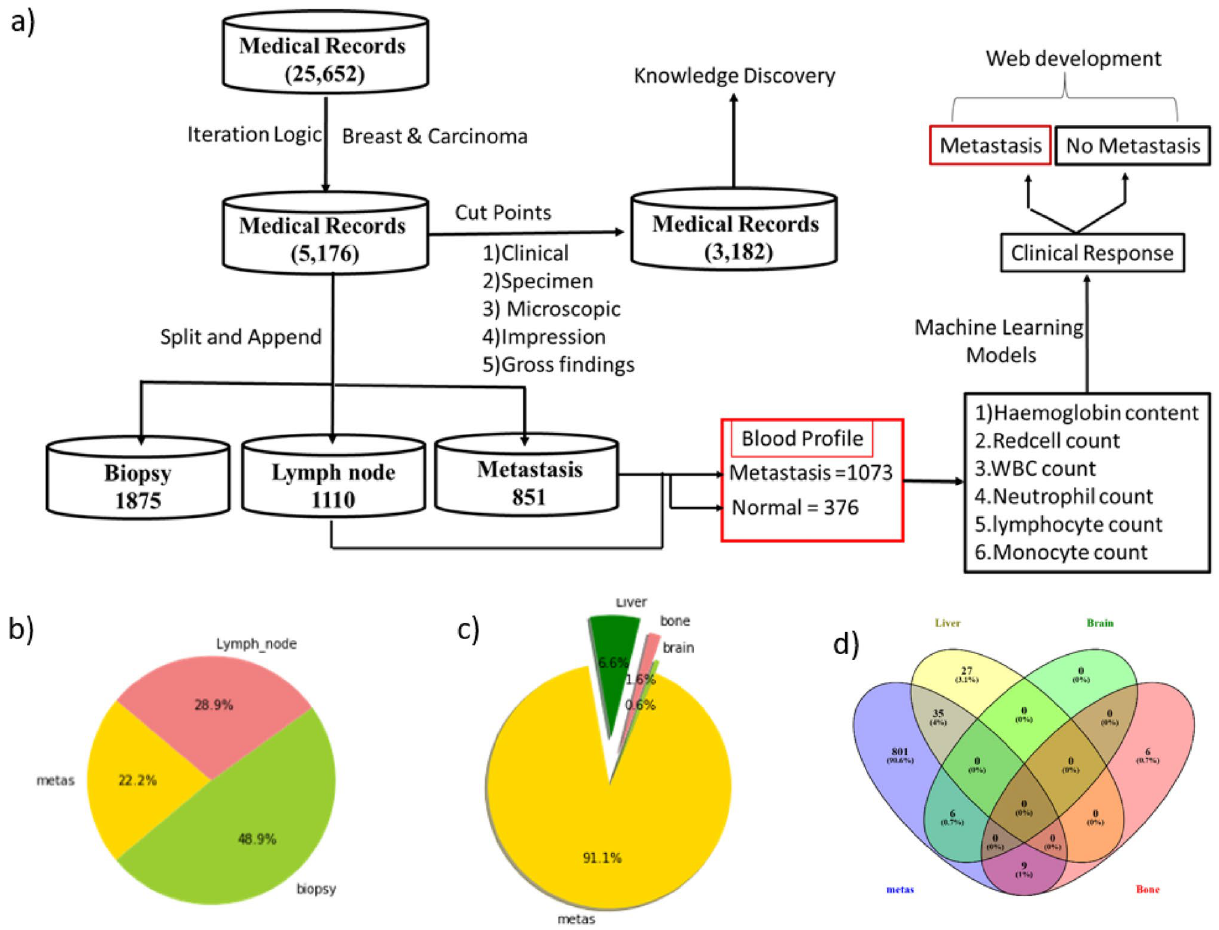
Figure 2. Text analytics based on clinical notes of breast cancer patients ( a ) A text mining framework for detecting cancer using blood profile data. ( b ) A pie chart depicting the proportion of patients who have metastasis and lymph node involvement. ( c ) A pie chart depicting the percentage of disseminated cancer cells in the liver, bone, and brain of patients with metastatic breast cancer. ( d ) Venn diagram representing the number of medical records intersecting between "metas" and bone, brain, and